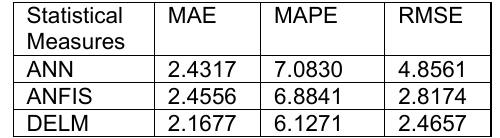
Table 2. Average values of statistical measures [11] Statistical